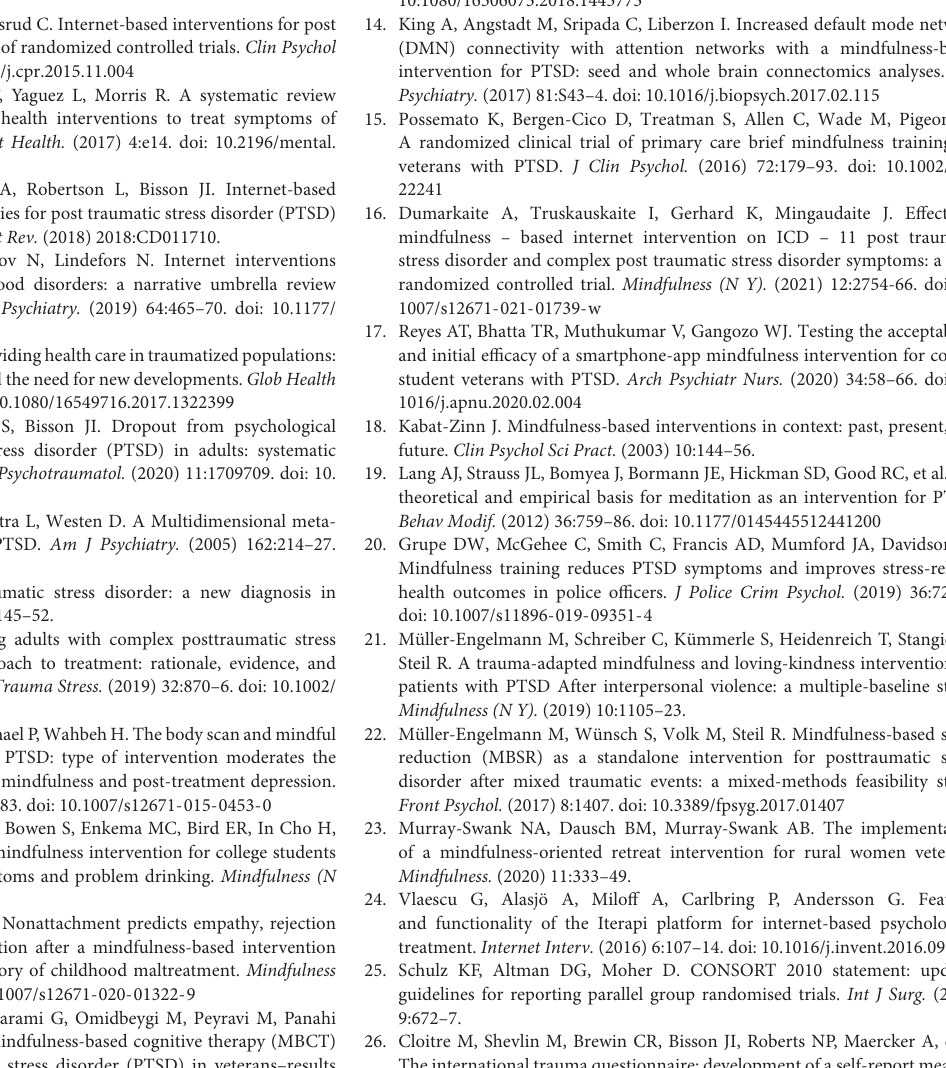
Supplementary Figure 1 | Screenshot of the